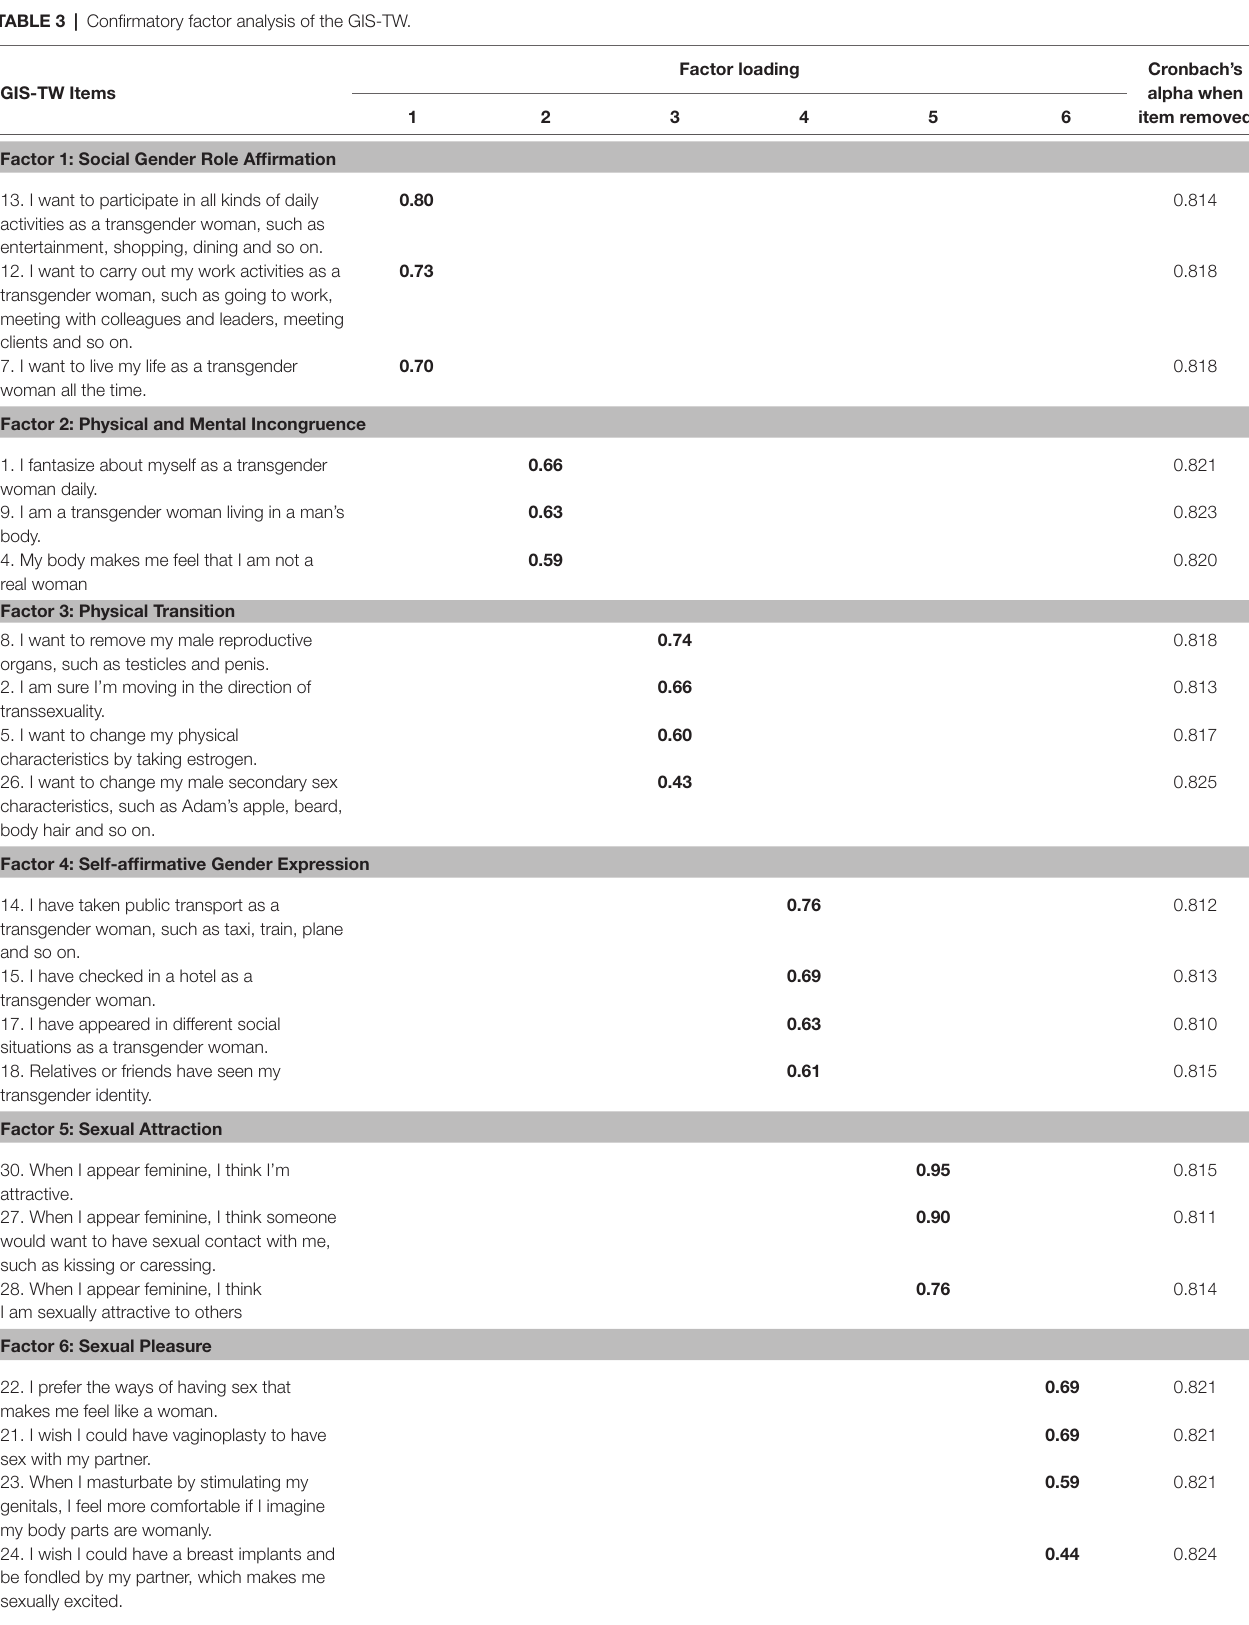
Factor loading Cronbach’s